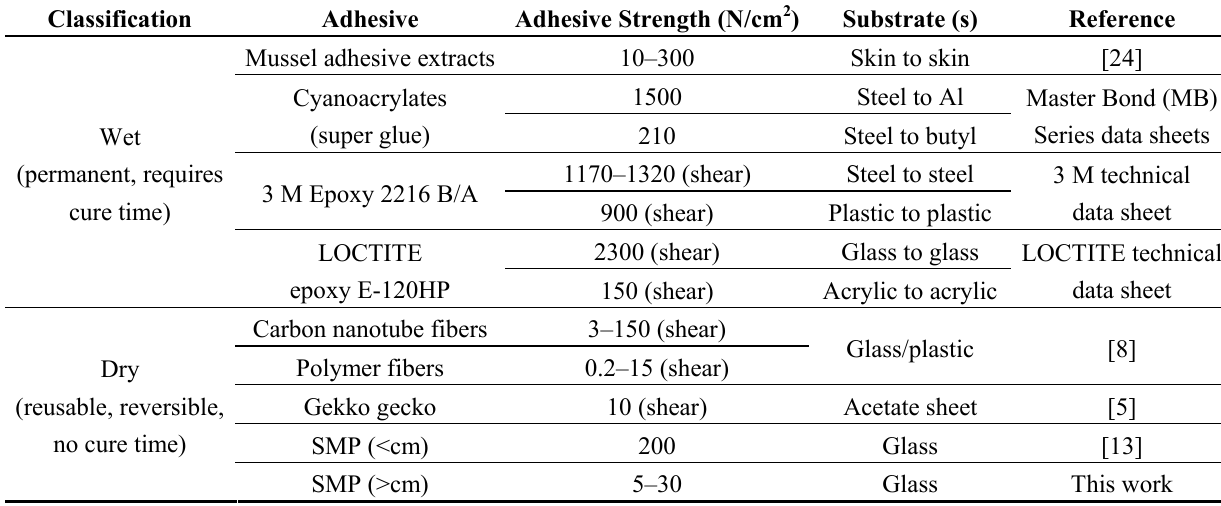
Table 3. Conventional “wet” adhesive and representative fibrillar dry adhesive strength for comparison to the adhesive described in this